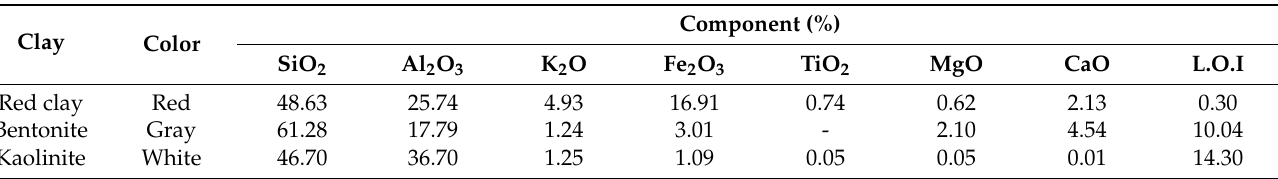
Table 2. Chemical components of the red